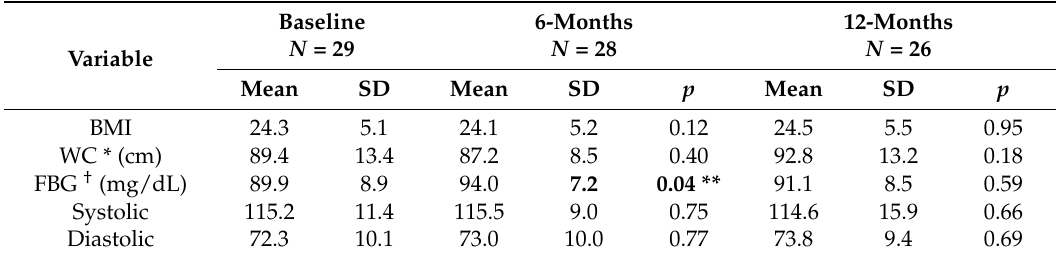
Table 2. The physical health metrics at enrollment and at six and twelve